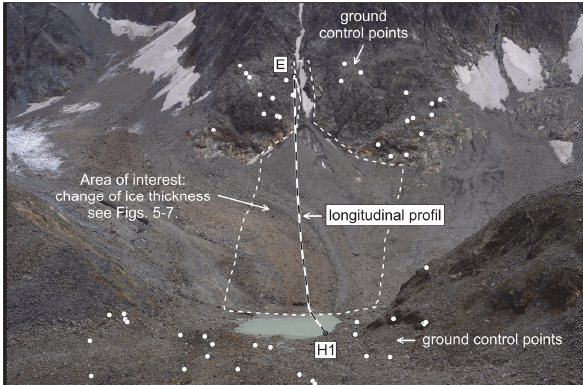
Figure 4. Nikon D300 digital image (21 Aug. 2015, taken at position R) showing the central part of Gössnitzkees. Ground control points (GCPs), the longitudinal profile, and the area of interest are